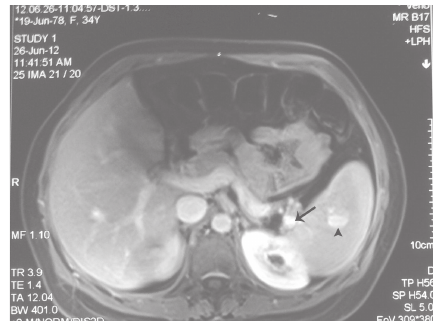
Figure 1: Axial T1W image with IV contrast of the upper abdomen (venous phase) showing two abnormal rounded enhancing intra- parenchymal (arrow head) and hilar (arrow) splenic lesions consis- tent with aneurysms.